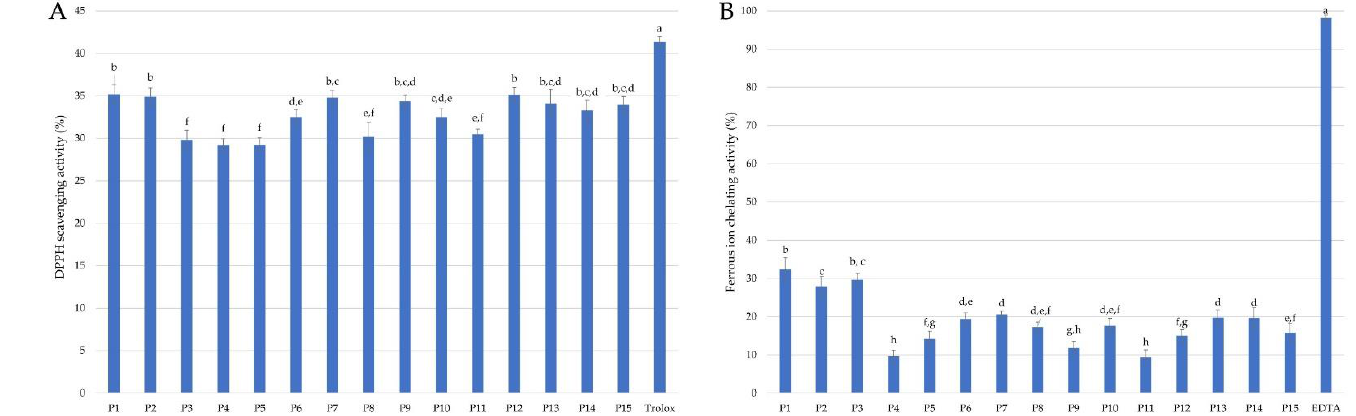
Figure 2. DPPH free radical scavenging activity ( A ) and ferrous ion chelating activity ( B ) of propolis extracts used at the concentration 0.1 mg/mL. (Values denoted with identical letters do not differ significantly).